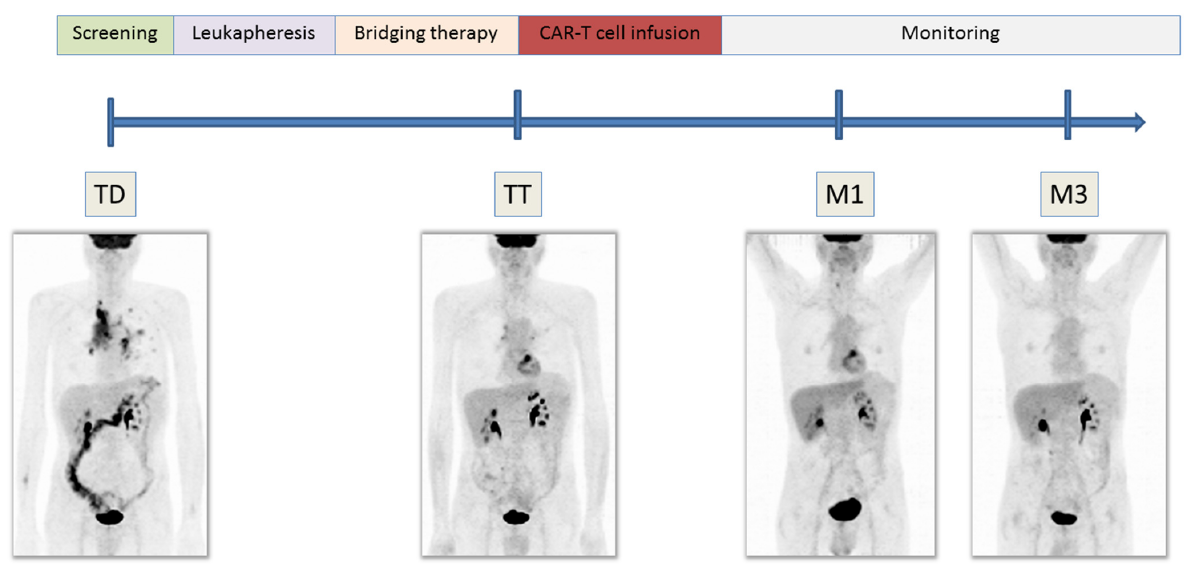
Figure 1. Schematic illustration of the time line for CAR-T cell therapy and corresponding schedules for [ 18 F]FDG PET/CT imaging, respectively at TD (time of decision), TT (time of transfusion), M1 (1 month after CAR-T cell infusion), and M3 (3 months evaluation after CAR-T cells infusion). Table 2. Summary of available studies investigating [ 18 F]FDG PET/CT in lymphoma treated with